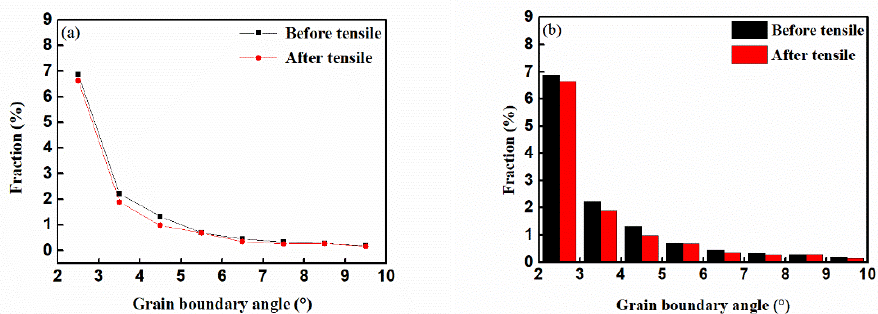
Figure 8. Low-angle grain boundary distributions of GH4169 alloy samples before and after tensile treatment: ( a ) Graph of grain boundary angle; ( b ) Histogram of grain boundary angle. (The picture has been replaced with a higher quality).